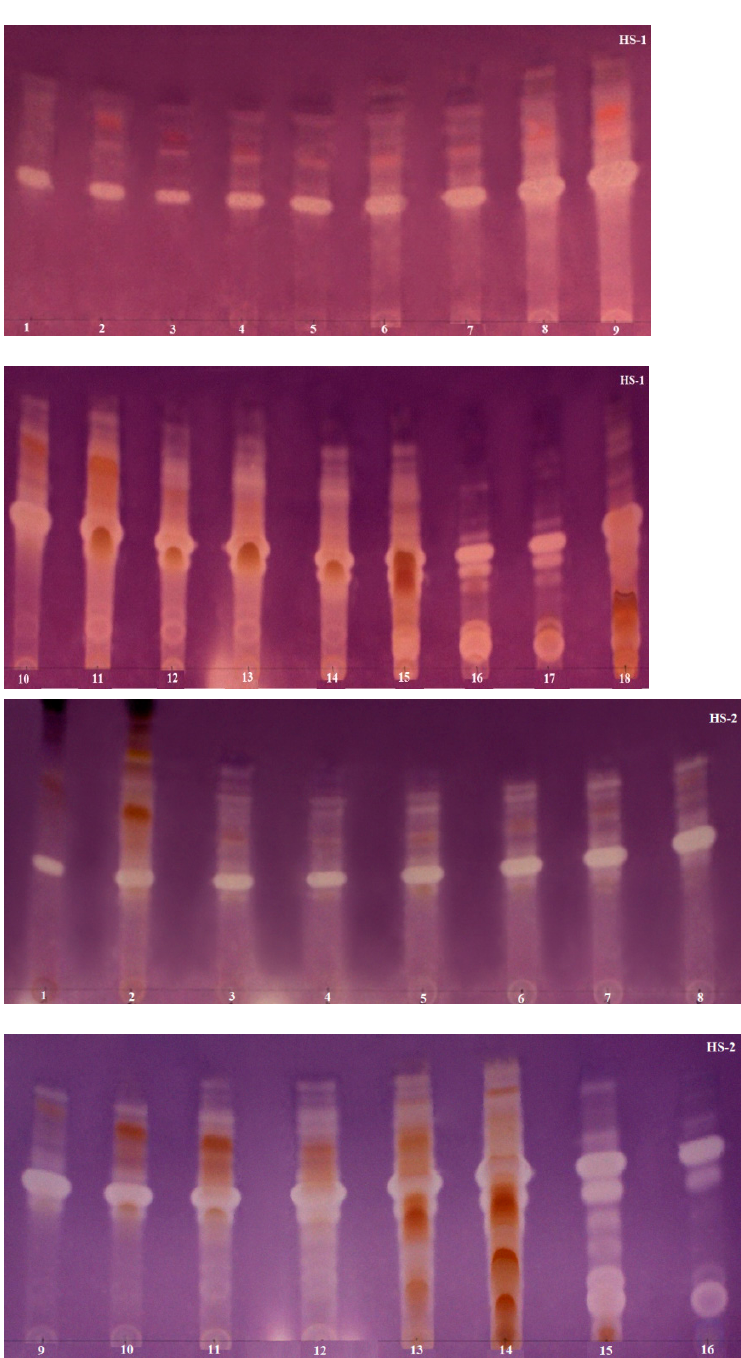
Figure 2. TLC chromatograms presenting H. selago fractions obtained from two experiments after acetylcholinesterase assays. HS ‐ 1 shows 18 fractions obtained from the first experiment via VLC using Al 2 O 3 and silica gel in ratio 1:3 as sorbents; HS ‐ 2 shows 16 fractions obtained from the second experiment via VLC using Al 2 O 3 and silica gel in ratio 3:1 as sorbents. Significantly weaker white zones of inhibition are found on TLC plates for samples obtained from two Lycopodium species. Fractions obtained via VLC for L. annotinum were